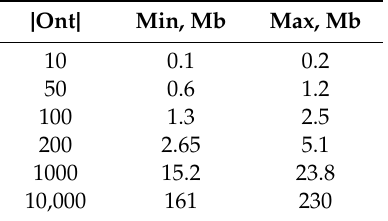
Table 3. Consumption of RAM depending on the dimension of the ontology. | Ont